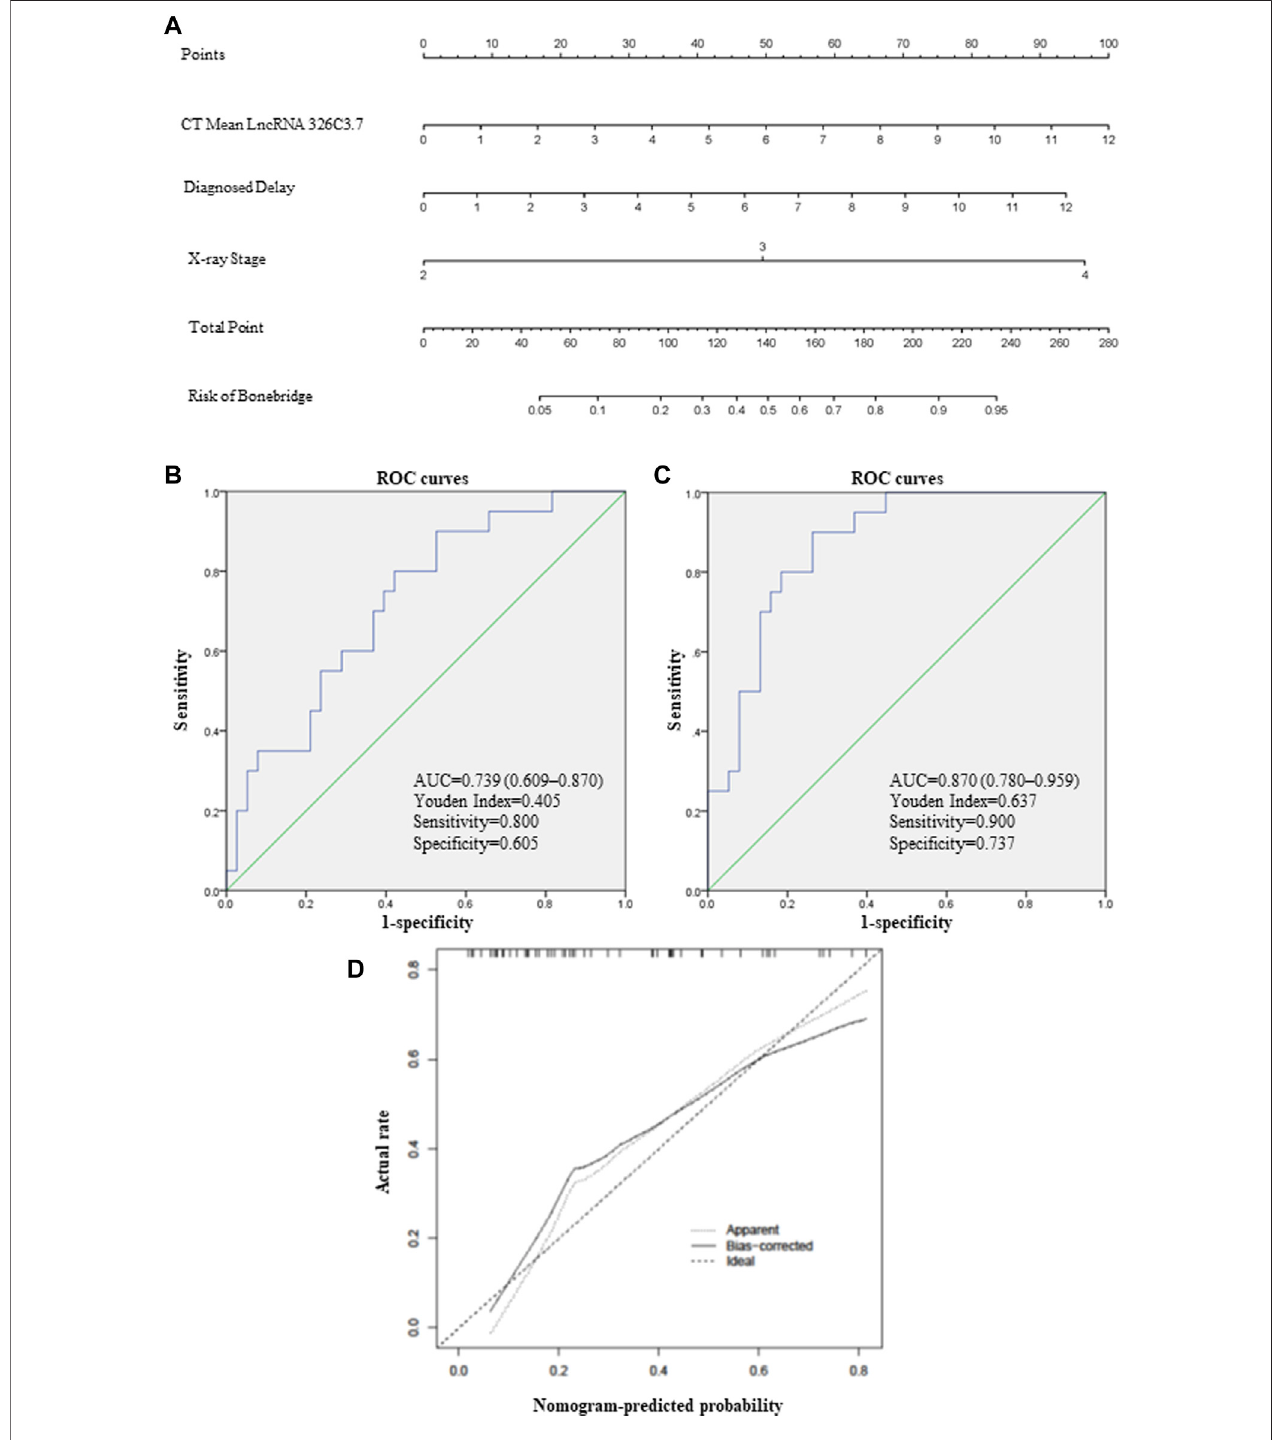
FIGURE6| lncRNA-basednomogramtopredictbonebridgeformationinASpatients. (A) Nomogram,avisualizationofthelogisticregressionmodel.Instructions: locate each characteristic on the corresponding variable axis, and draw a vertical line upward to the point ’ s axis to determine the speci fi c point value. Repeat this process. Tally up thetotal point ’ svalue, and locate iton the total point ’ s axis. (B) ROC curve depicting the predictive accuracy oflncRNA 326C3.7. AUC, areaunder the curve. (C) ROC curve depicting the predictive accuracy of the nomogram. (D) Calibration plot of the nomogram for predicting bone bridge formation. The 45- degree dotted line represents a perfect prediction, and the solid line represents the nomogram ’ s predictive performance.